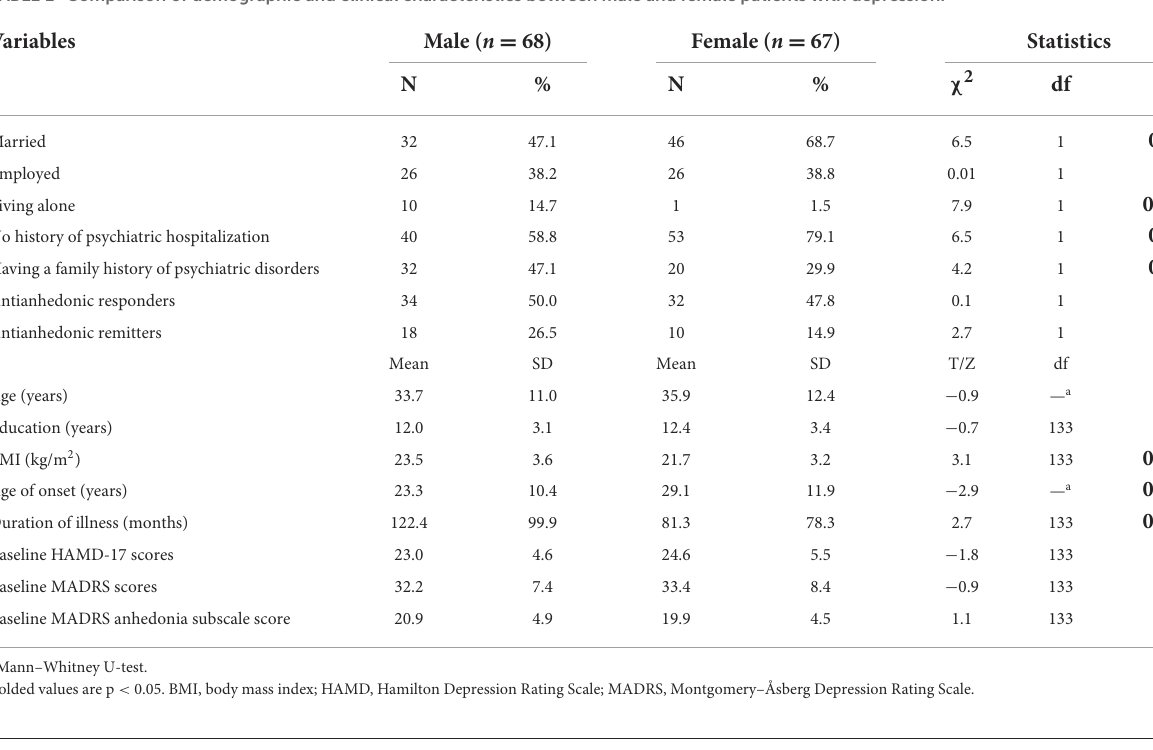
TABLE 1 Comparison of demographic and clinical characteristics between male and female patients with depression.